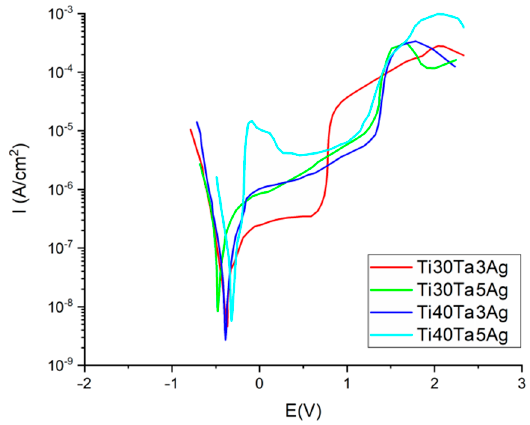
Figure 5. Potentiodynamic corrosion curves. Table 3. Corrosion potential E corr and corrosion current density I corr for the Ti-Ta-Ag alloys.